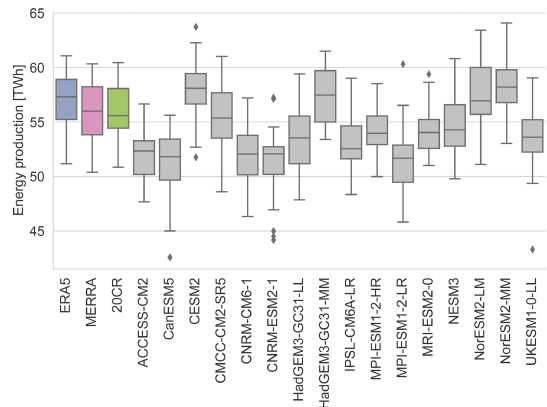
Figure 7. Net annual energy production of the Energy Island wind farm cluster calculated from the time series of the three reanalyses and the CMIP6 models (excluding the MIROC models) for the full historical period